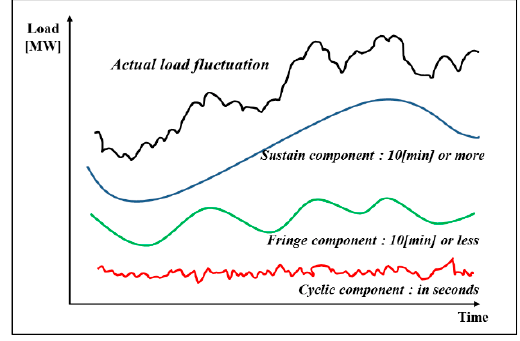
Figure 2. Periodic component of load fluctuation.